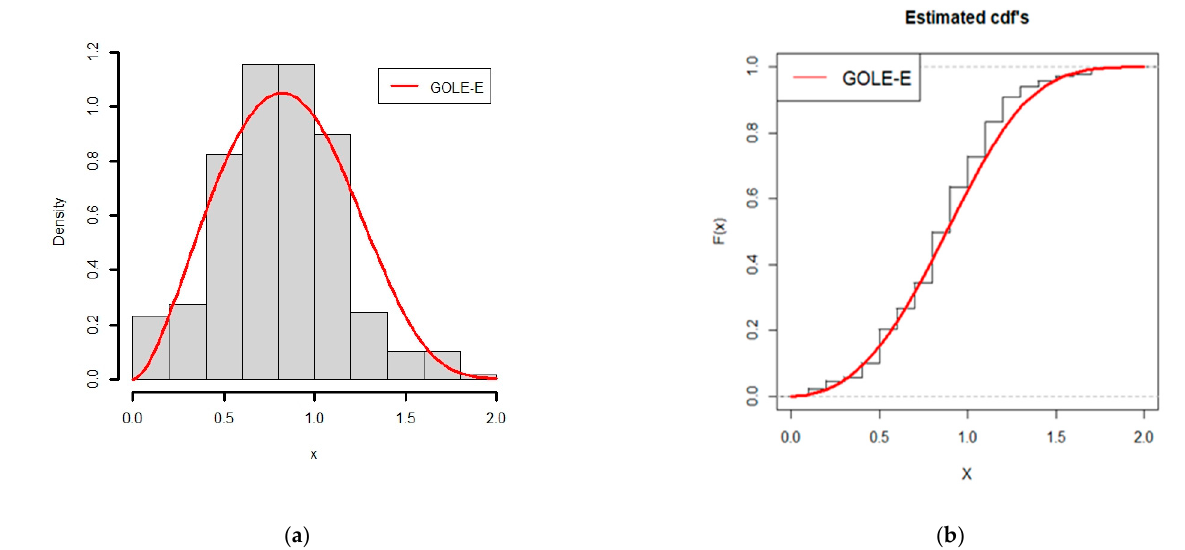
Figure 8. Plots of ( a ) the fitted PDF and ( b ) estimated CDF for the GOLE-E distribution for data set I. Table 5. MLEs, standard error (in parentheses) and confidence interval values [in brackets] for data set II.